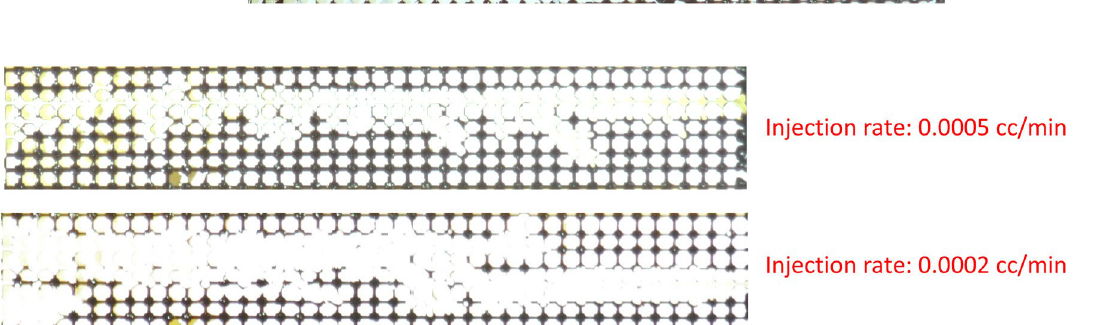
Fig. 7 Comparison between flooded pattern at breakthrough time for polymer type 2 for flow rates 0.0002 cc/min (lower side picture) and 0.0005 cc/min (upper side picture) both at concentration = 1500 ppm. Injection point on the left side (brown color: oil, white color: